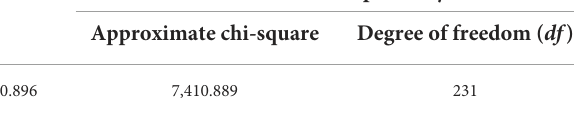
TABLE 2 KMO and Bartlett’s test of sphericity results.